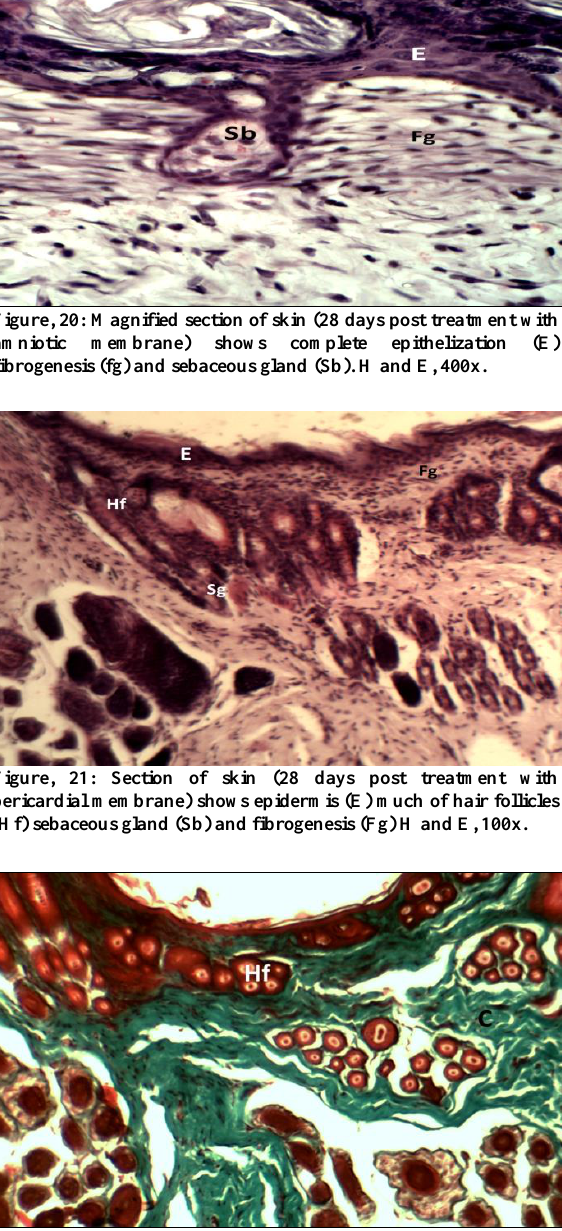
Figure, 22: Section of skin (28 days post treatment with pericardial membrane) shows much of hair follicles (Hf) and collagen bundles within dermis. Masson's trichrome stain, 143